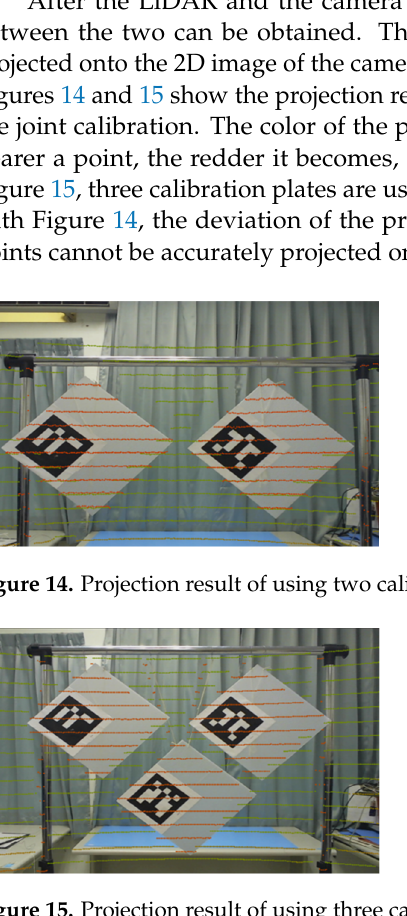
Figure 13. Results of using three calibration plates.